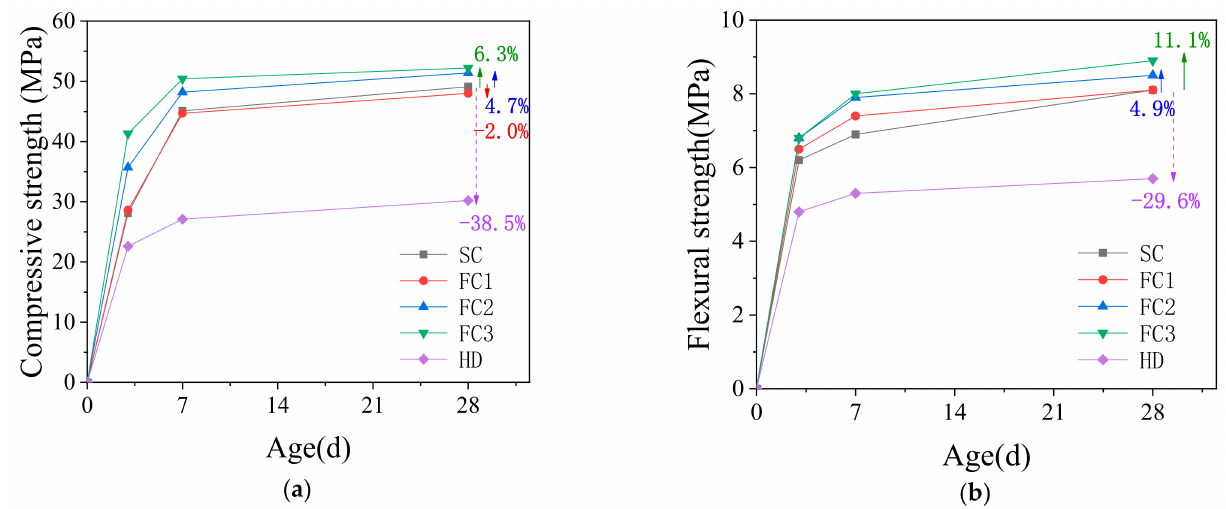
Figure 2. Strength of blank cement mortar (FA0-M), ( a ) Compressive strength and ( b ) Flexural